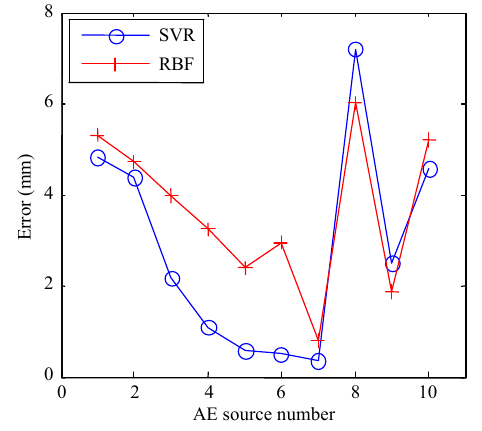
Fig. 8 Error of testing